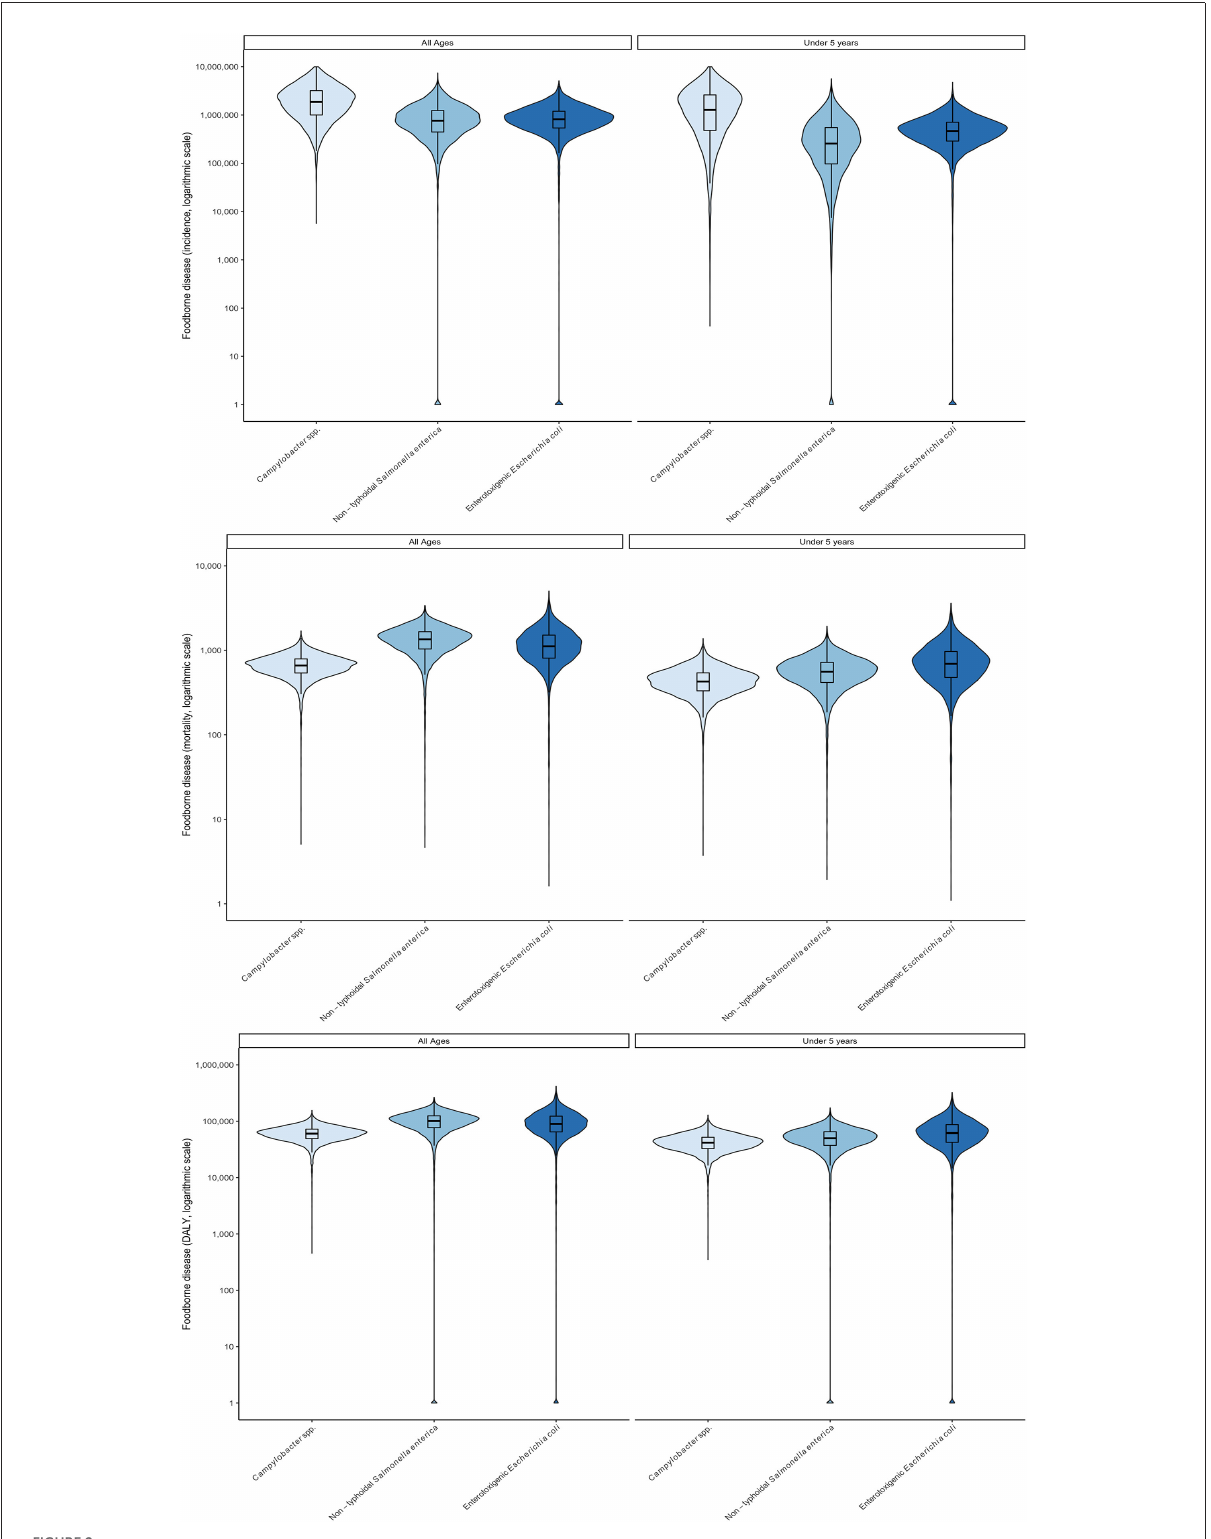
FIGURE2 Uncertainty in foodborne disease burden for three bacterial hazards and age groups in Ethiopia in 2017 (all ages) according to WHO FERG (1), updated according to the Global Burden of Disease study (8). (Top) incidence; (Middle) mortality, (Bottom) DALYs. See Figure 1 for explanation of violin